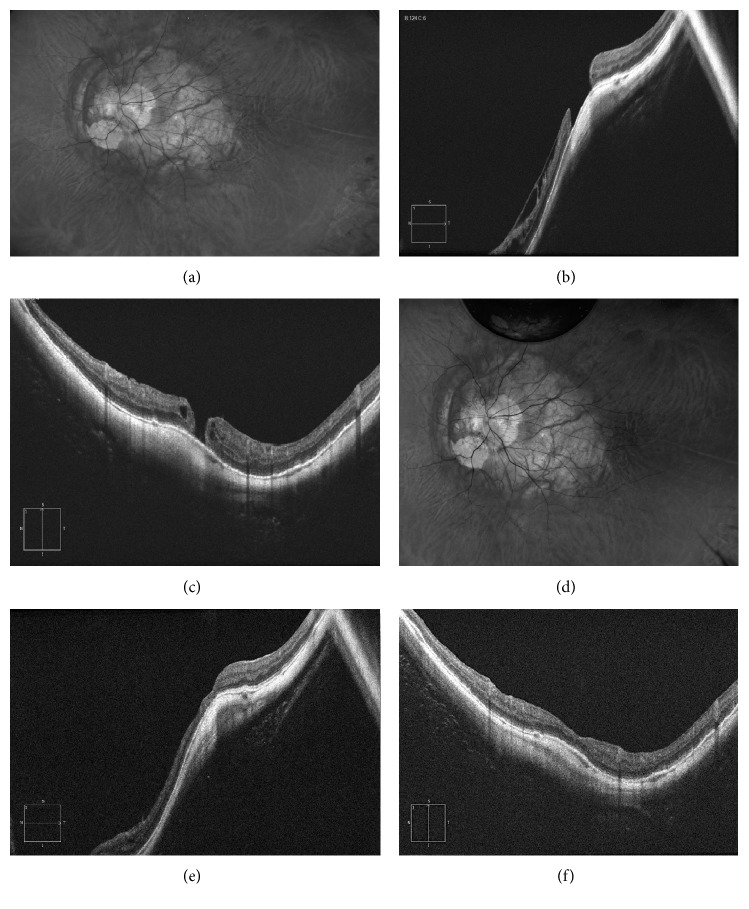
56-year-old man with an axial length of 38 mm and a BCVA of 20/400, with inner retinoschisis and a myopic macular hole. (a) Fundus retinography showing the posterior staphyloma involving macula and optic disc and the chorioretinal atrophy. (b, c) Structural horizontal and vertical OCT showing the inner retinoschisis and the macular hole of 650 microns. (d) Fundus retinography after vitrectomy and inverted flap technique. (e, f) Structural vertical and horizontal scan showing the closure of the macular hole, the resolution of the retinoschisis, and the restoration of all retinal layers.